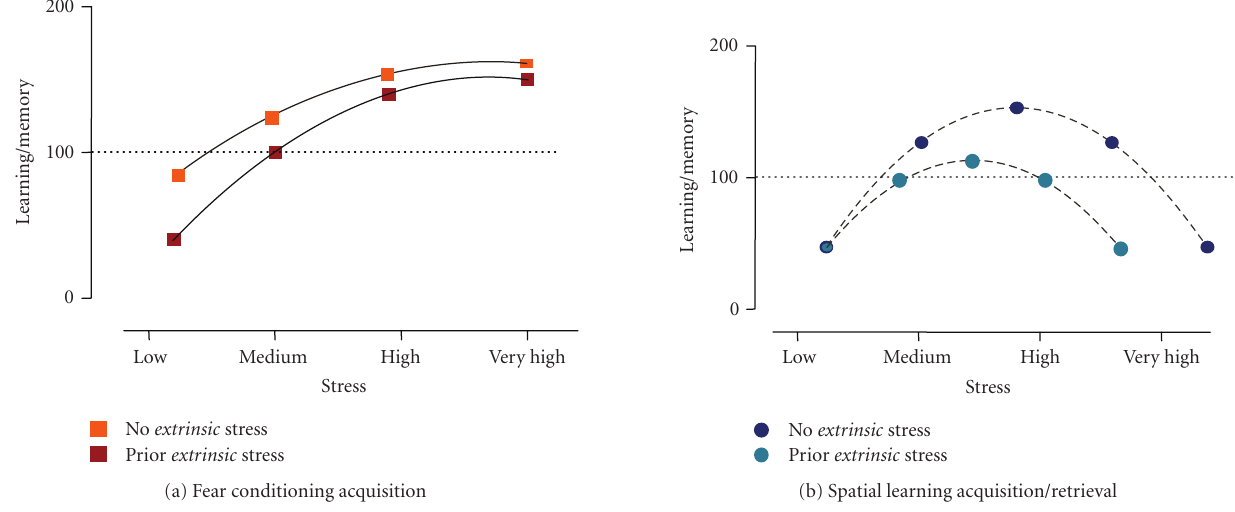
Figure 5: Impact of “chronic extrinsic” stress on memory formation. Chronic stress potentiates fear conditioning (a) and impairs spatial and reversal learning processes